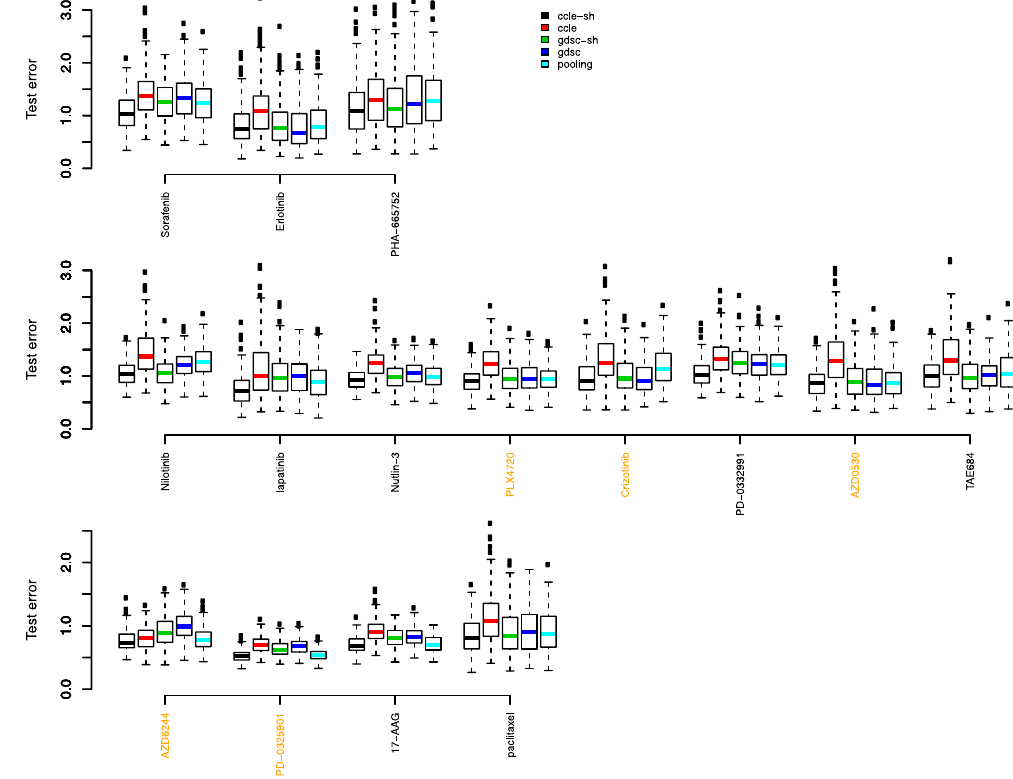
Figure 7. Test error rate boxplots by drug when 70% of 80% CCLE dataset were used in training data and 20% CCLE dataset were reserved as test data. Black represents predictions based on data sharing estimates for β alone; red for predictions from a model using GDSC alone; green for predictions from a data sharing model using estimates of β + δ ; blue for predictions from a model using CCLE alone, and light blue, predictions from a pooled GDSC + CCLE